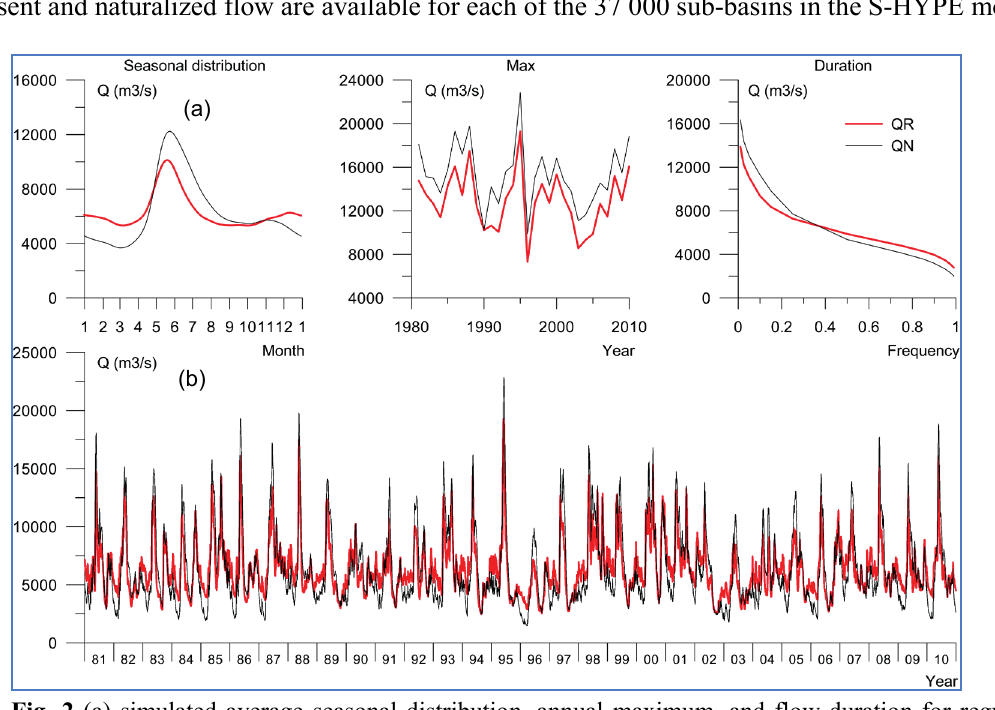
Fig. 2 (a) simulated average seasonal distribution, annual maximum, and flow duration for regulated and naturalized conditions, respectively, for total river-discharge from Sweden. QR = modelled river flow including regulation; QN = naturalized flow, both from HYPE simulations. (b) daily time-series of the modelled period 1981–2010, with and without